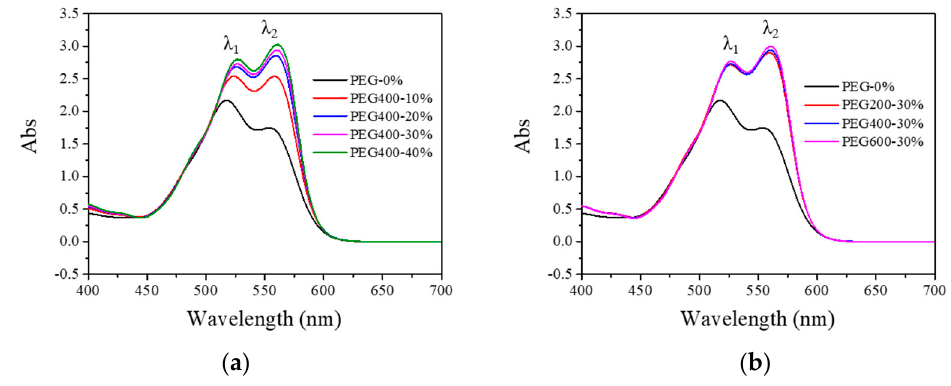
Figure 2. Visible absorption spectra of 7% Red 218 and PEG solutions at 25 °C. ( a ) For different amounts of PEG400; ( b ) For PEG200, PEG400, and PEG600 at 30% by weight. Table 1. The absorption peak positions of PEG–dye aqueous solutions.